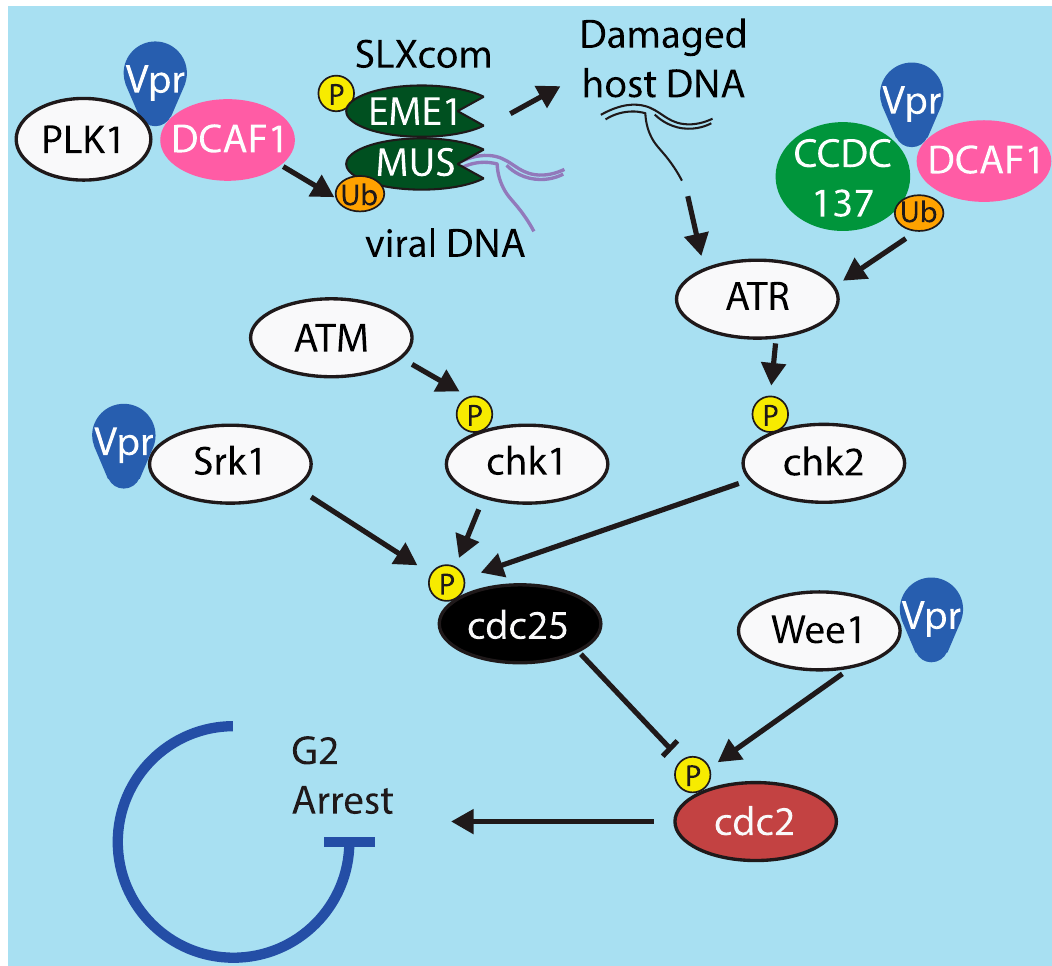
Figure 5. Model of G2/M cell cycle arrest and mechanisms by which it is affected by Vpr. Graphical depiction of the cdc2-mediated cell cycle arrest pathway, including points at which Vpr has been demonstrated to alter signaling in order to promote arrest.